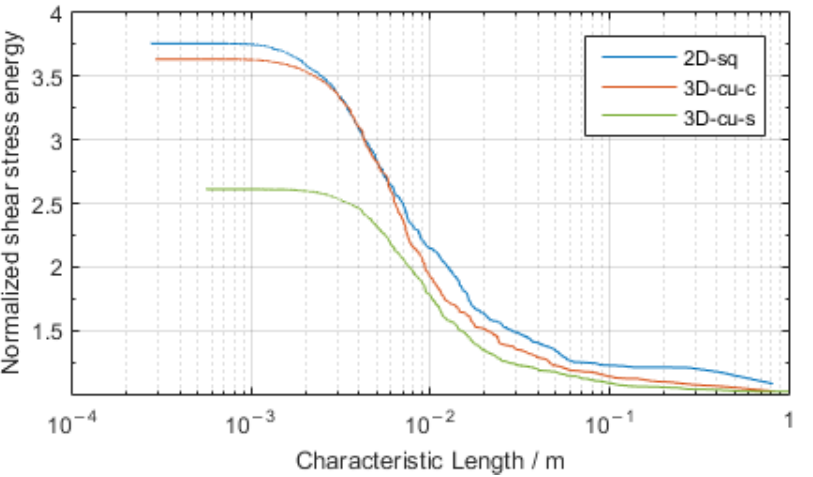
Figure 13. Normalized energy of instantaneous shear stress signal of each case on characteristic length of vortex (from large scale to small scale) at type B locations. Normalization is performed by dividing (𝑢 (cid:4593) 𝑣 (cid:4593) (cid:3364)(cid:3364)(cid:3364)(cid:3364)(cid:3364)(cid:3364)) (cid:2870) , the energy of time-averaged shear stress.